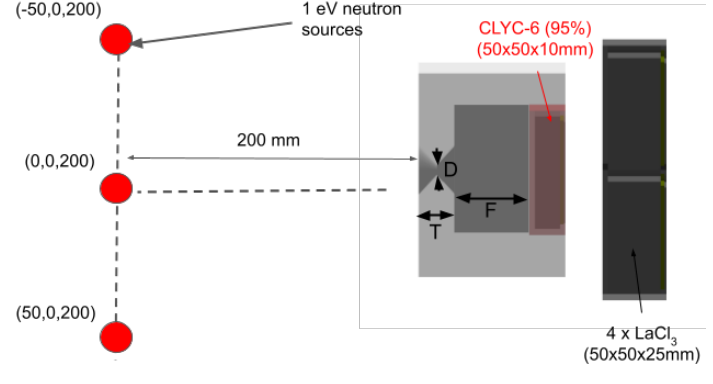
Fig. 2. Sketch of the geometry model of GN-Vision implemented in Geant4 for the conceptual demonstration of the neutron imaging capability.